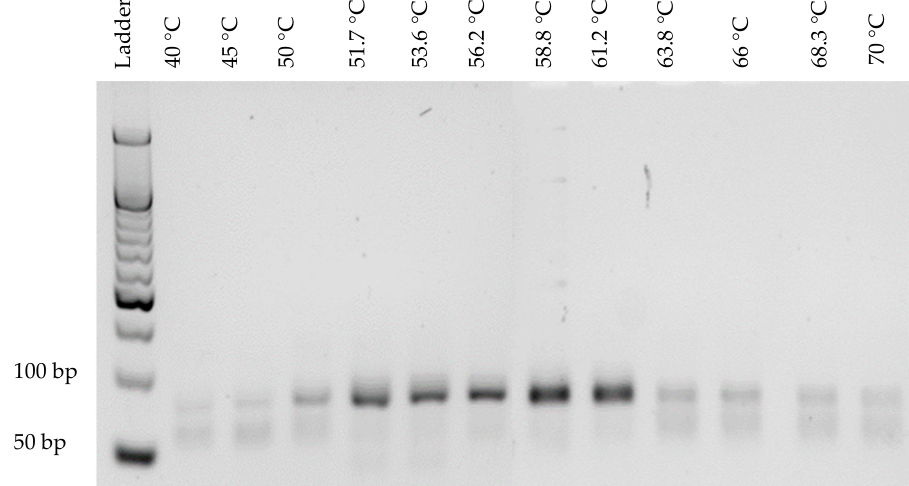
Figure 2. Agarose gel electrophoresis (4% agarose, 90 V, 2 h in TAE 1 × GelRed ® ) of the PCR products, after variable numbers of amplification cycles (from 6 to 25 cycles) performed with an annealing temperature of 58 °C. The legends above the gel correspond to the number of amplification cycles.